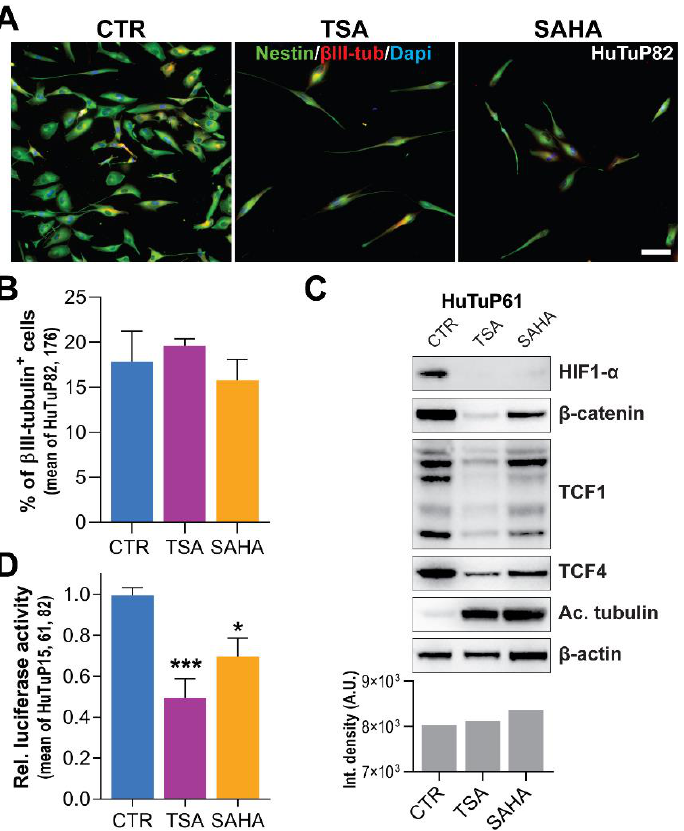
Figure 3. Reduction of GBM cell stemness is not accompanied by acquisition of a differentiated phe- notype due to Wnt signaling suppression. ( A ) Representative immunofluorescence images display- ing Nestin (green) and βIII -tubulin (red) expression of HuTuP82 cells after 5-d exposure to TSA (0.2 μM ) and SAHA (0.5 μM ). Cell nuclei were counterstained with Dapi (blue). Original magnification 10×; bar: 30 μm . ( B ) Quantification of βIII -tubulin+ cells by immunofluorescence as in ( A ) (mean of HuTuP82 and HuTuP176 GBM cells). ( C ) Western blot analysis of indicated proteins extracted from HuTuP61 cells treated for 24 h with TSA (5 μM ) and SAHA (5 μM ) (upper panel). The original Western blot images included in Figure 3C are provided in Supplementary Figure S3B. Bar graph reporting total protein quantitation (integrated density) by Coomassie staining of WB samples (bot- tom panel). ( D ) Bar graph reporting relative luciferase activity of GBM cells (mean of HuTuP15, 61 and 82) transfected with BAT-lux plasmid and then treated for 24 h with HDI (5 μM ). A.U.: arbitrary units. * p < 0.05, *** p < 0.001 by One-way ANOVA multiple comparison test.